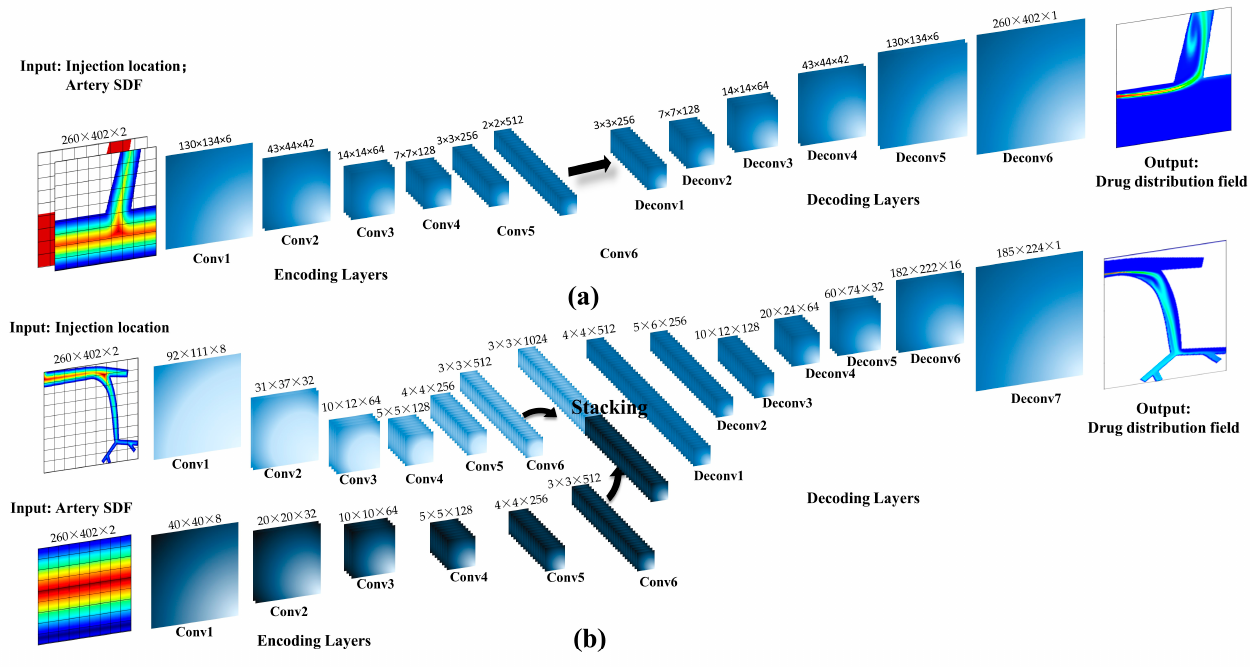
Figure 4. Architecture of the two CNN models: ( a ): Model 1; ( b ): Model 2.